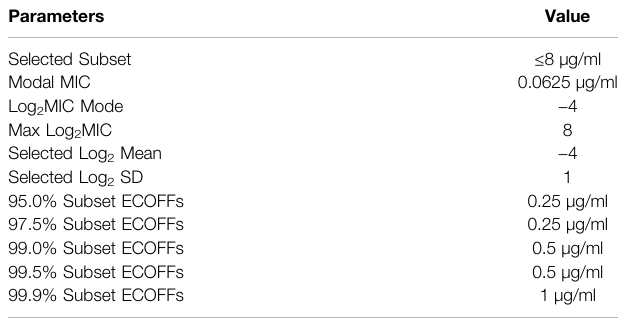
TABLE 2 | ECOFFinder analysis for avilamycin against Clostridium perfringens .